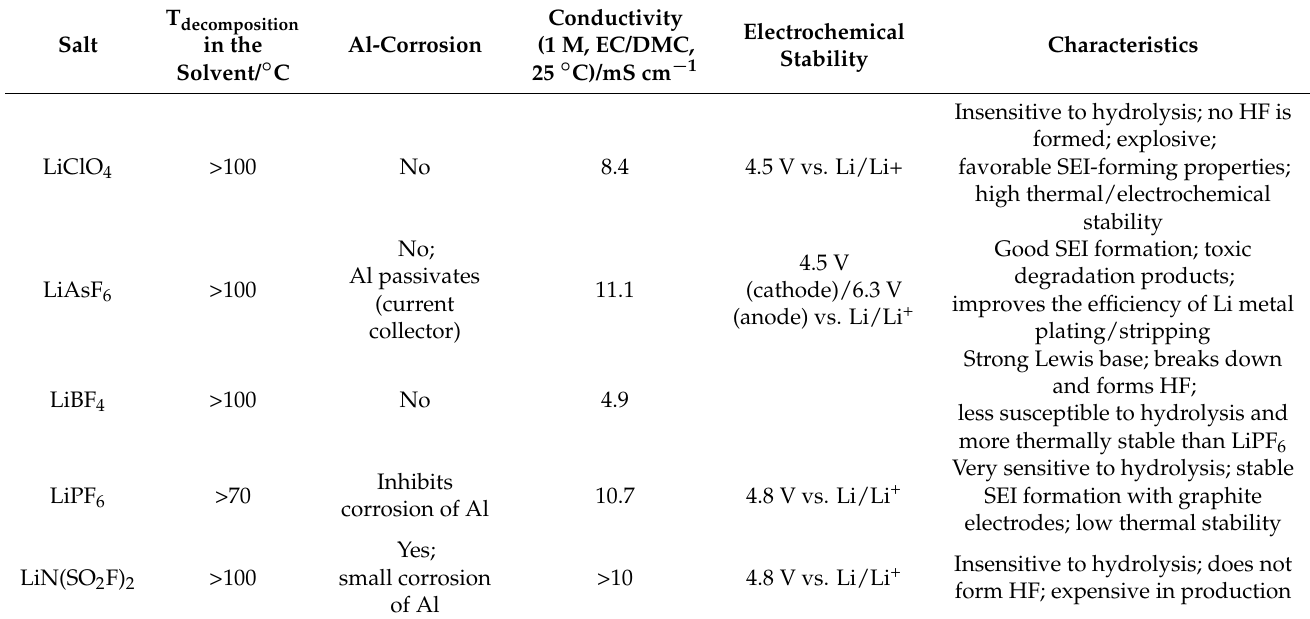
Table 1. Properties of the most commonly used non-aqueous conductive salts in